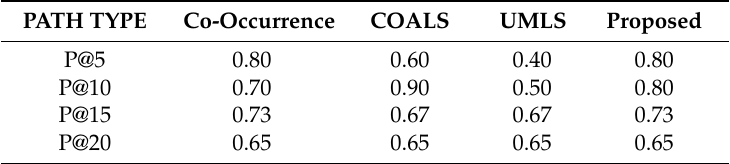
Table 7. Comparison of precision at n (where both type 1 and 2 = true and type 3 = false). PATH TYPE Co-Occurrence COALS UMLS